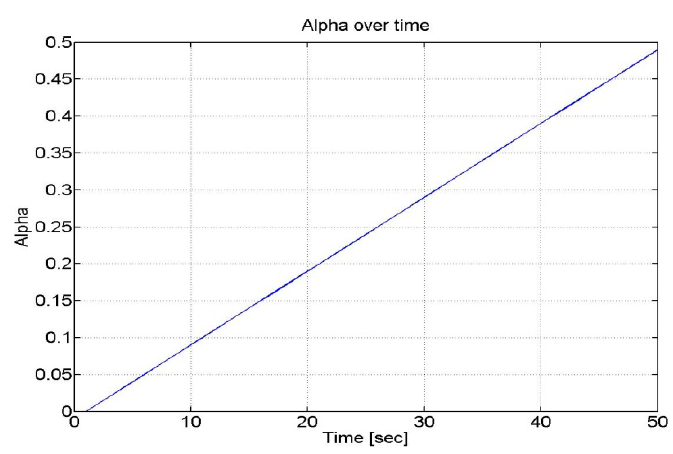
Figure 15. α design for Kalman